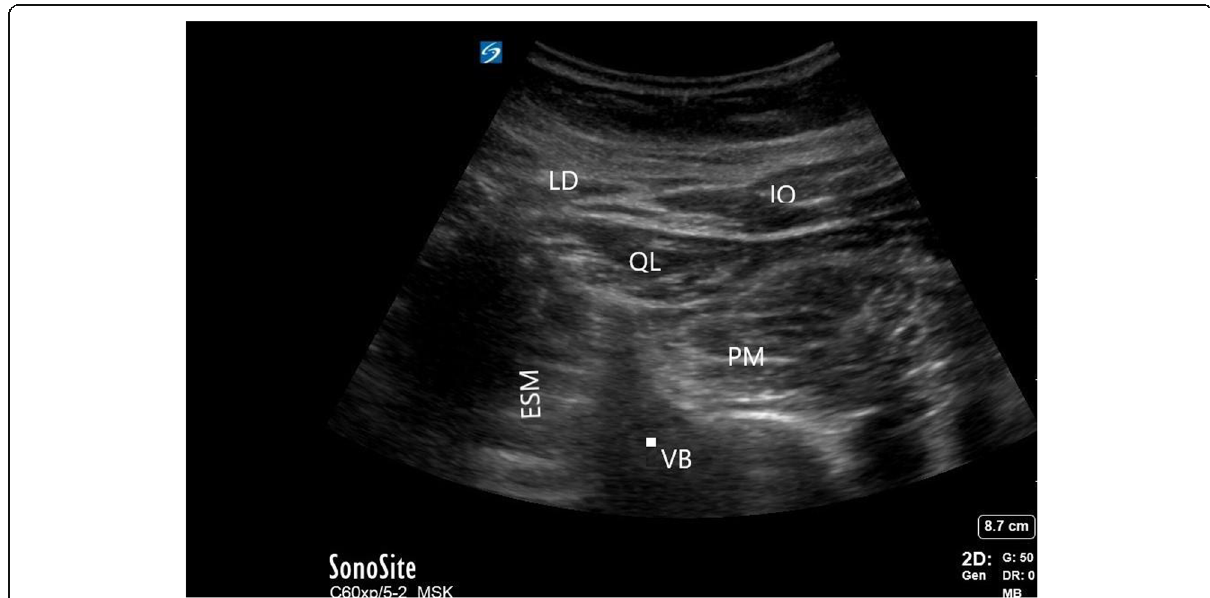
Fig. 1 ESM erector spinae muscle, IO internal oblique muscle, LD latissimus dorsi muscle, PM psoas major muscle, QL quadratus lumborum muscle, TA transversus abdominis muscle, VB vertebral body and transverse